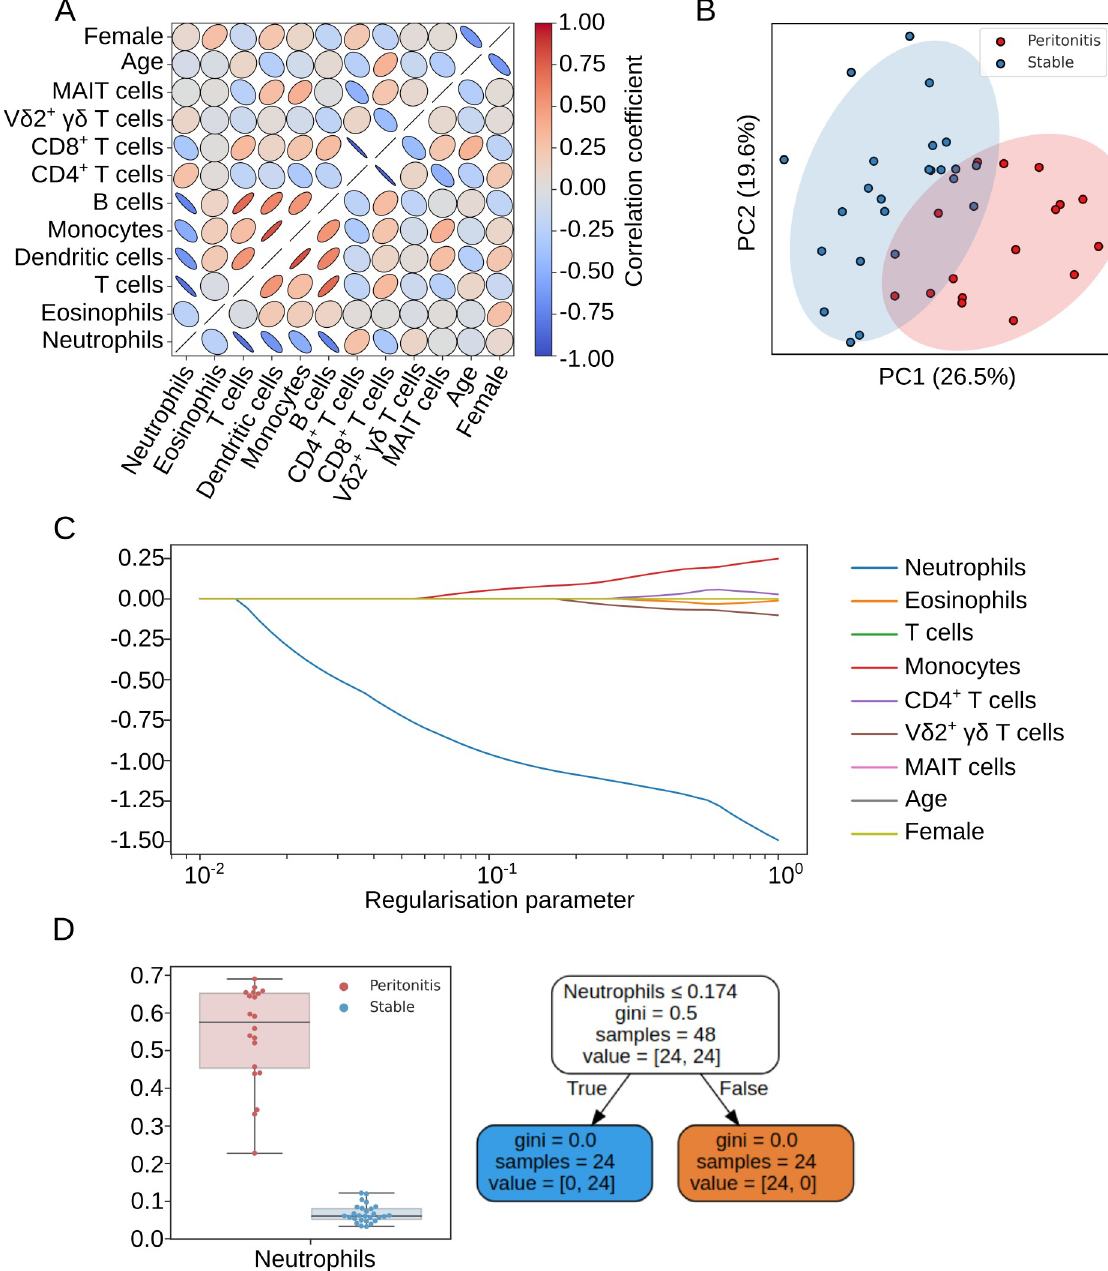
Fig 9. Feature selection process to reduce variables for predicting acute peritonitis. (A) Multicollinearity was addressed before generating linear models with redundant features removed prior to further analysis. (B) Principal component analysis shows that patients with acute peritonitis are discernible from stable controls. (C) L1 restricted modelling with a linear support vector machine reveals that neutrophils are the most predictive feature. (D) A simple cutoff applied to neutrophils is predictive of acute peritonitis in this cohort and is demonstrated by a shallow decision tree, where gini index is the chosen criterion for measuring the quality of split.